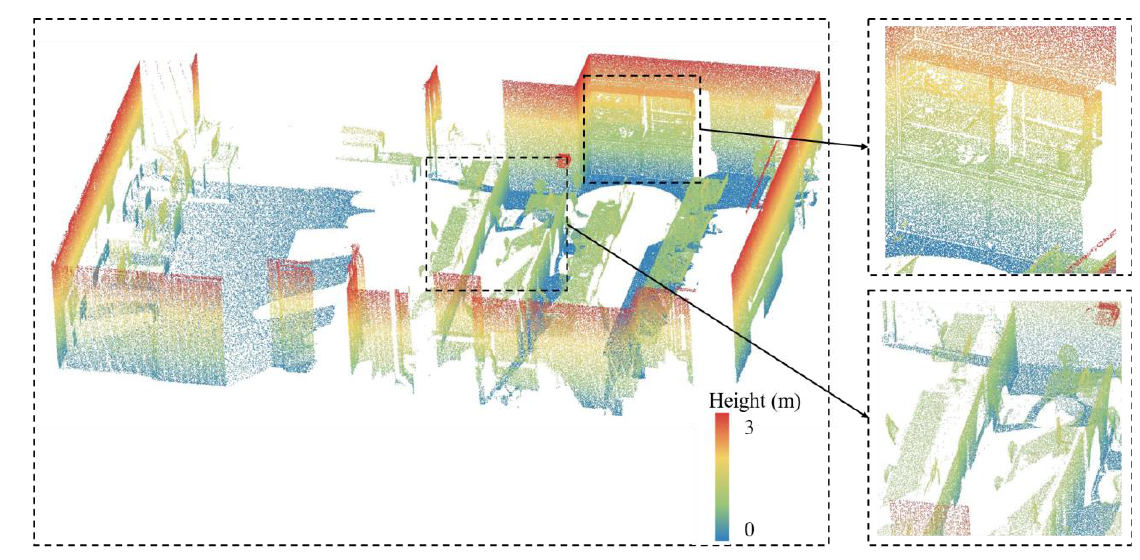
Figure 11. Laboratory dataset with height as the color bar.